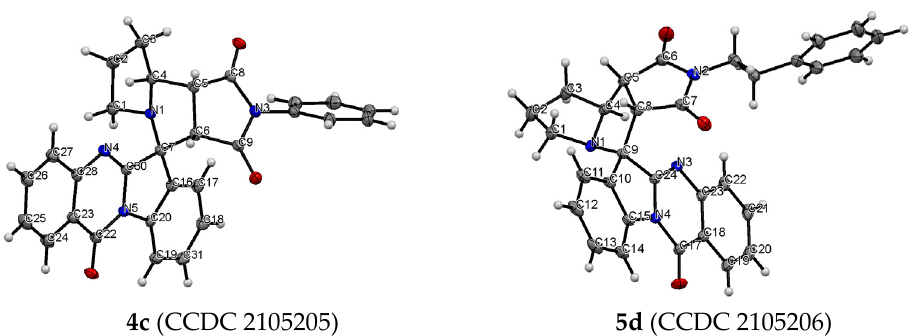
Figure 1. ORTEP representation of the molecular structure of 4c and 5d.